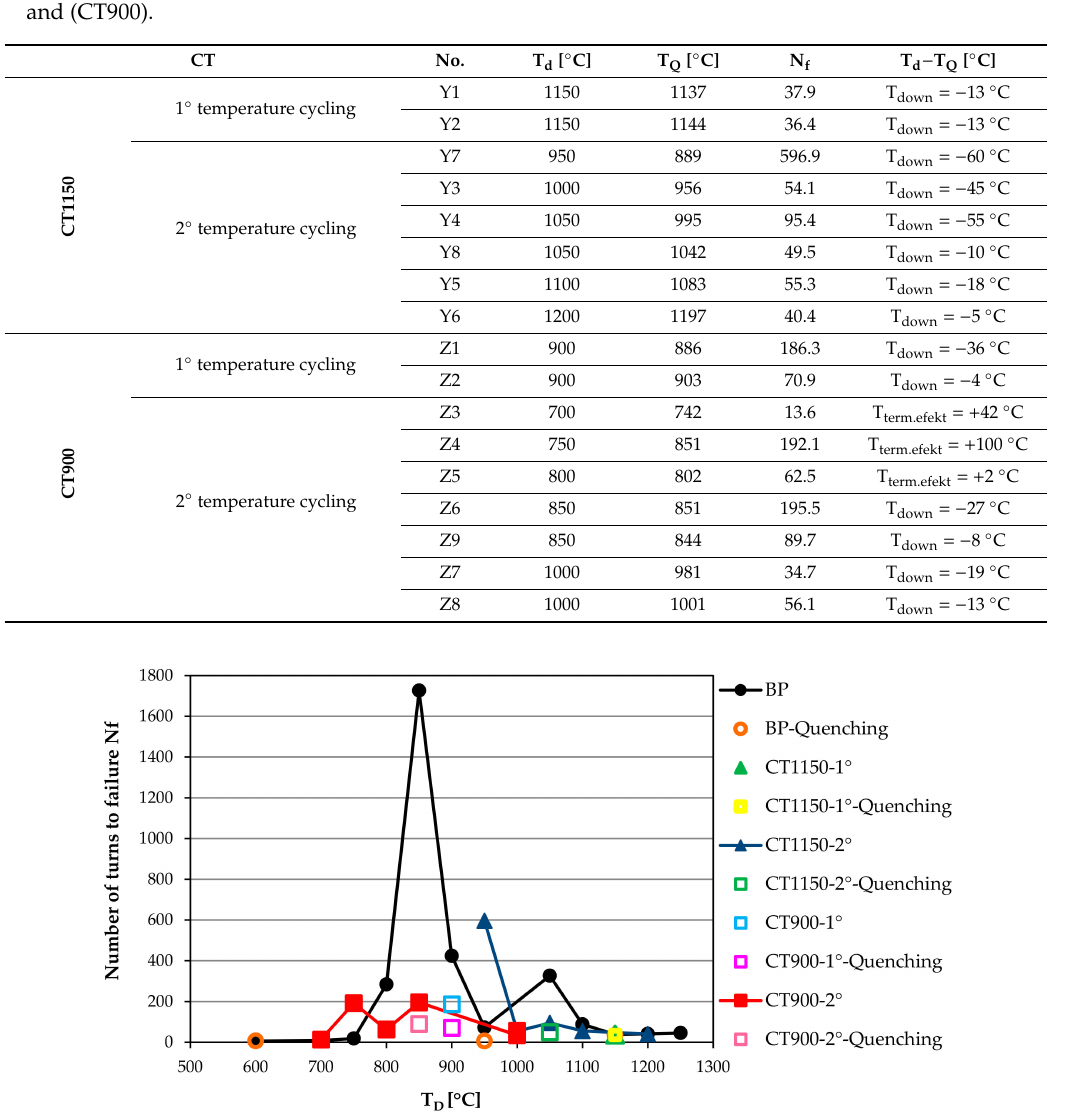
Figure 3. Temperature dependence of the number of turns to failure N f in the basic programme and of 1 ◦ , 2 ◦ temperature cycling in programme CT900 respectively CT1150 as well as quench